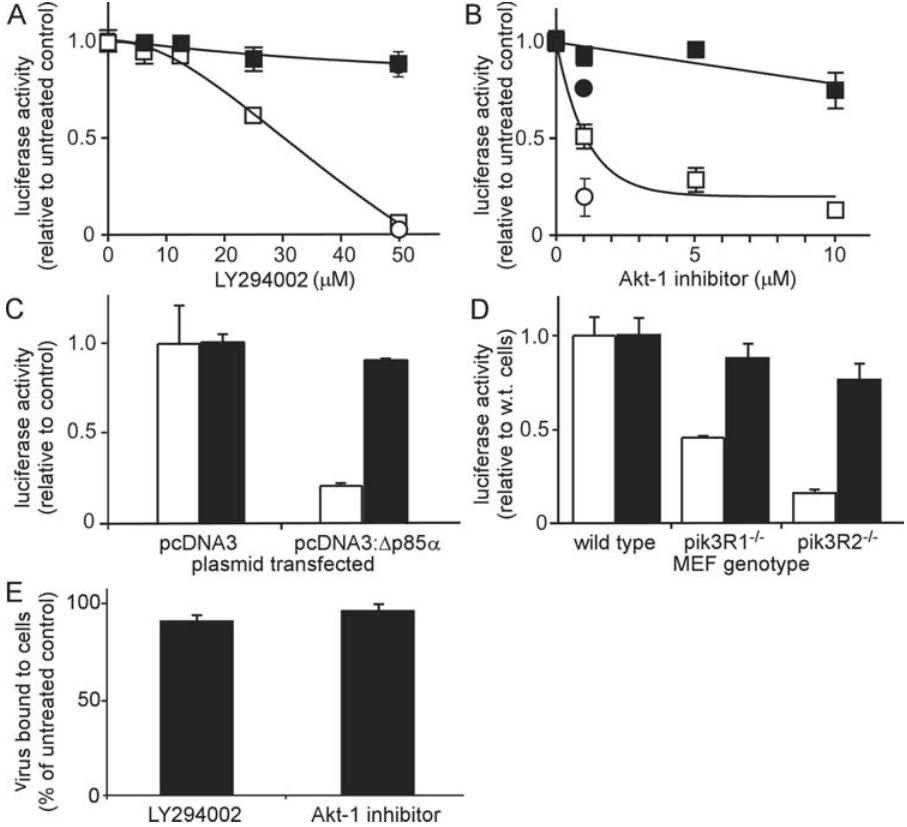
Figure 4. PI3K-Akt-1 pathway plays a critical role in Ebola virus entry. (A) HEK293-mCAT-1 cells were pre-treated with the indicated concentrations of LY294002 for 1 h followed by incubation with ZEBO-VLP (open squares), VSV-VLP (closed squares), EVP (open circle), or VSVP (closed circle) for 3 h in the continued presence of the drug. Entry signals were then measured. Data were normalized to luciferase activity in DMSO (vehicle)-treated cells. (B) HEK293-mCAT-1 cells were pre-treated with the indicated concentrations of Akt inhibitor for 1 h followed by incubation with ZEBO-VLP (open squares), VSV-VLP (closed squares), EVP (open circle), or VSVP (closed circle) for 3 h in the continued presence of the drug. Entry signals were then measured. Data were normalized to luciferase activity in DMSO (vehicle)-treated cells. (C) HEK293-mCAT-1 cells were transfected with either pcDNA3 or pcDNA3 encoding a dominant-negative form of the PI3K p85- a regulatory subunit ( D p85 a ). Entry assays were performed 36 h after transfection using ZEBO-VLP (open bars) or VSV-VLP (solid bars). Data were normalized to luciferase activity in untransfected cells. Each data point represents the mean 6 SD of 3 experiments. (D) Wild-type (WT), pik3R1 2 / 2 (p85 a , p55 a , and p50 a -deficient), or pik3R2 2 / 2 (p85 b -deficient) mouse embryonic fibroblast (MEF) cells were incubated with EVP (open bars) or FrVP (solid bars). After 3 h, cells were washed, and luciferase activity was measured. Each data point represents the mean 6 SD of 3 independent experiments. (E) HEK293-mCAT-1 cells were pre-treated with LY294002 (50 m M) or Akt-1 inhibitor (1.0 m M) for 1 h at 37 u C, followed by incubation with ZEBO-VLPs for 10 min at room temperature. Cells were then washed to remove unbound virus and resuspended in luciferase assay buffer containing triton X-100 detergent; luciferase activity was then measured. Data were normalized to luciferase activity in vehicle-treated samples. Each data point represents the mean 6 SD of 2